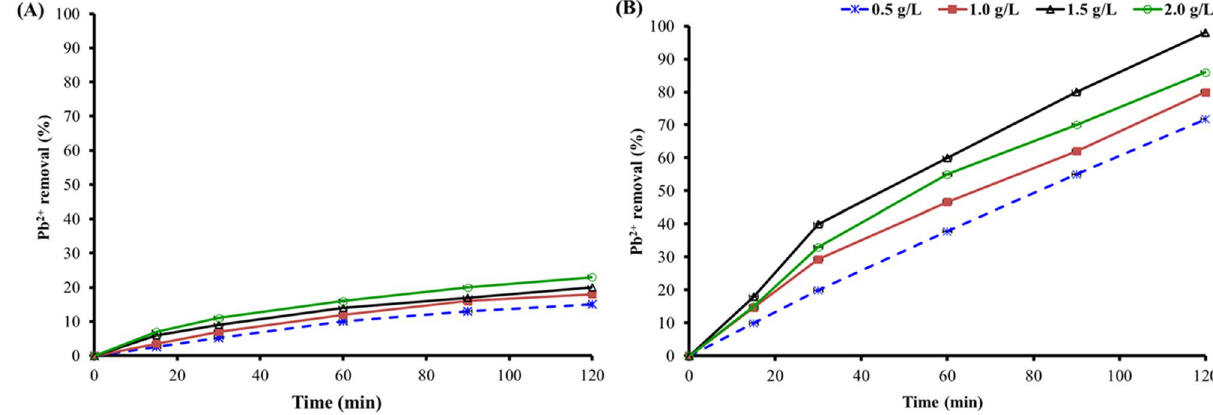
Figure 6. Impact of loading dose for adsorption of Pb 2+ ions. ( A ) neat PES ( B ) PES/biosorbents. Satandard division bar.